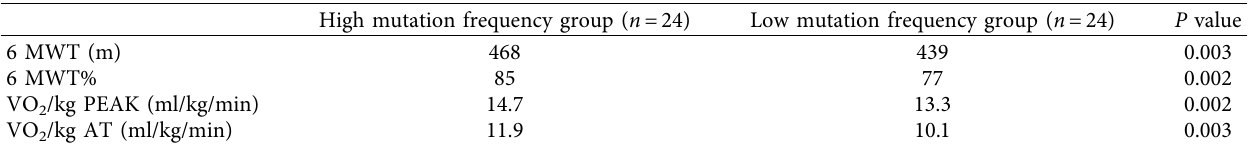
Table 3: Comparison of exercise ability indices after 8 weeks of exercise intervention.